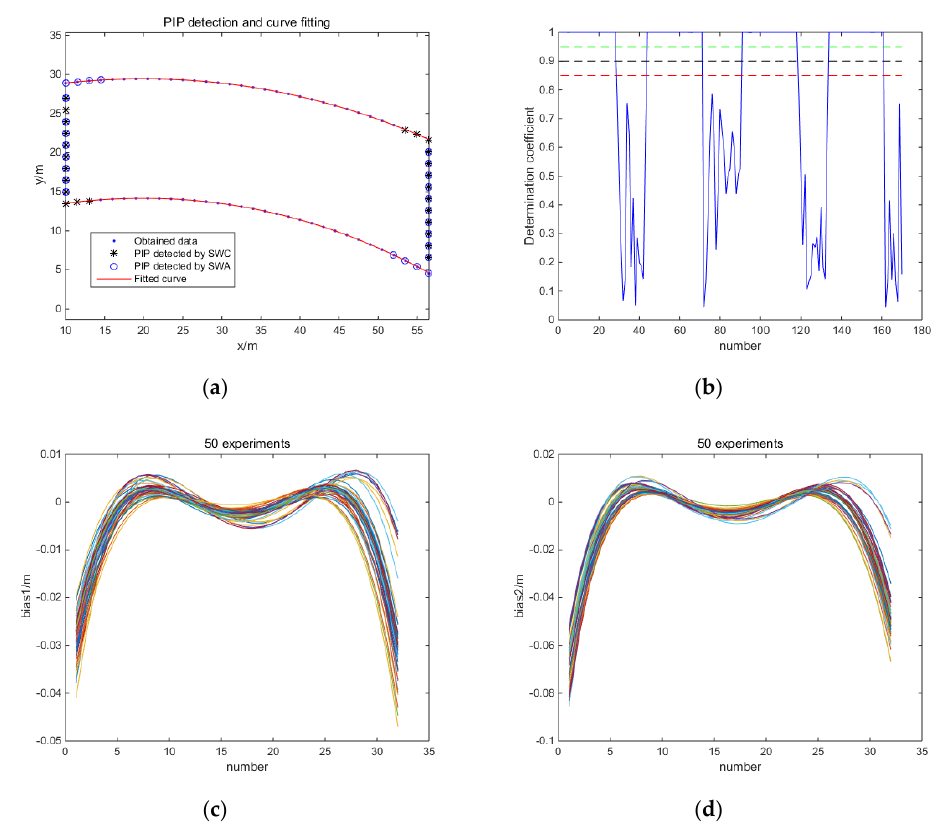
Figure 14. PIP detection ( a ); determination coe ffi cient of the sliding window at each point and the set threshold 0.85 (red), 0.9 (black), 0.95 (green) ( b ); and bias between the acquired data and corresponding point data on the curve ( c , d